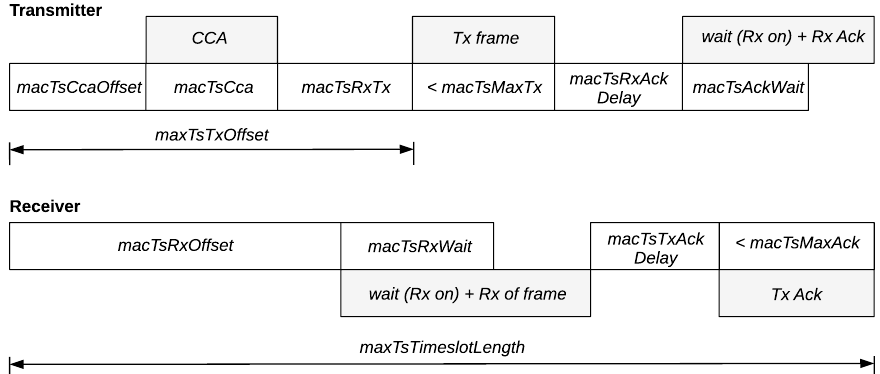
Figure 8. The IEEE802.15.4-TSCH timeslot